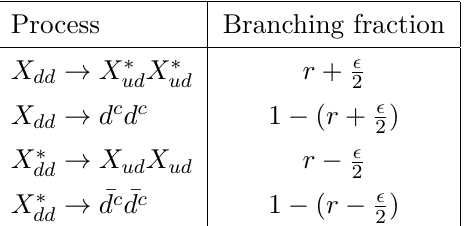
Table 4 . Two-body decay modes of X dd and the corresponding branching